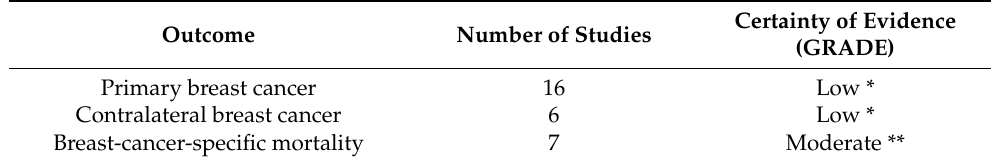
Table 3. Grading of Recommendations, Assessment, Development and Evaluations (GRADE) assess- ment of certainty of evidence per